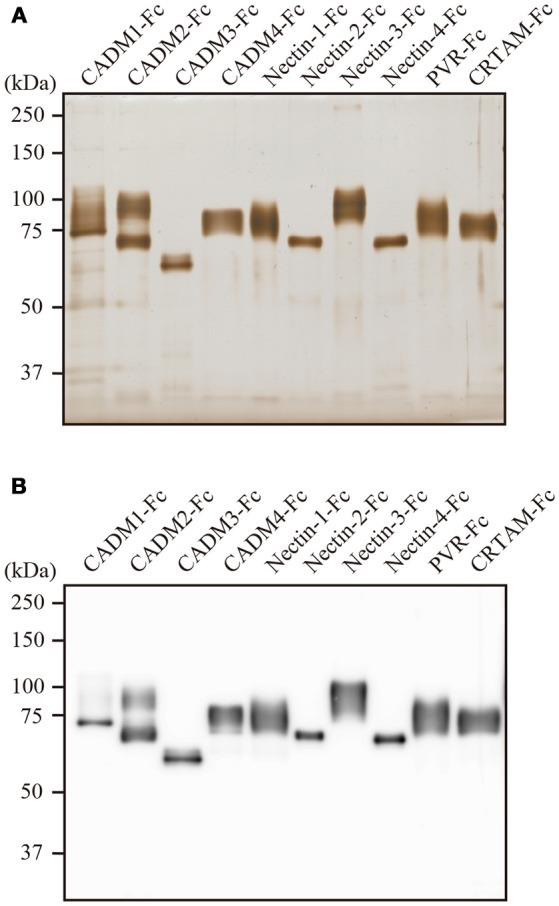
Characterization of the purified IgSF-Fc proteins. (A) Silver staining of the purified IgSF-Fc proteins. Each 100 ng of IgSF-Fc protein was fractionated in a 7.5% SDS-PAGE gel. (B) Western blotting of the purified IgSF-Fc proteins using an anti-human IgG-Fc antibody.